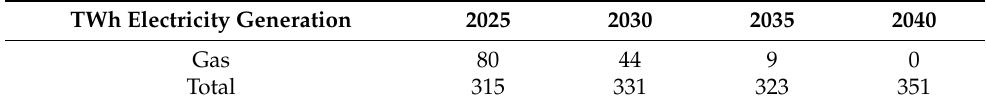
Table 3. The proportion of gas by the energy of the UK electricity generation forecasted for the years